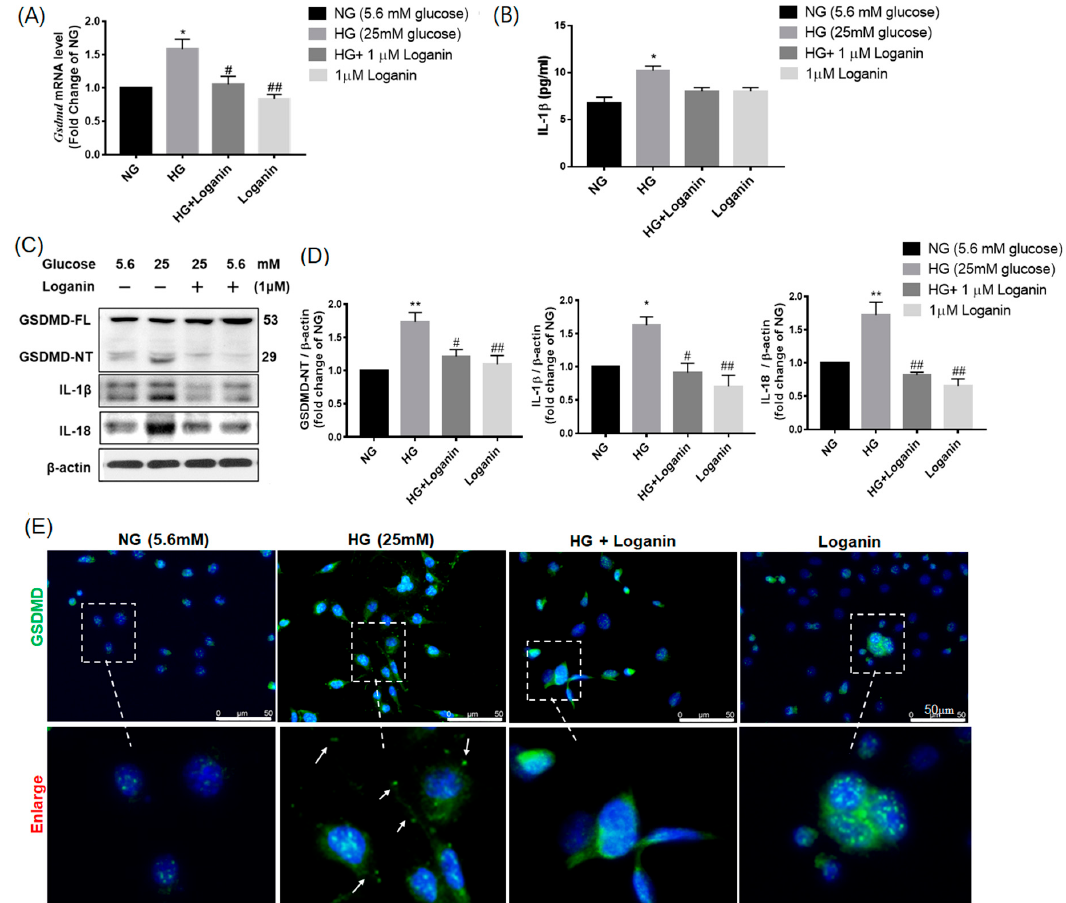
Figure 6. Loganin effects on gasdermin D (GSDMD)-mediated pyroptosis in high-glucose-treated